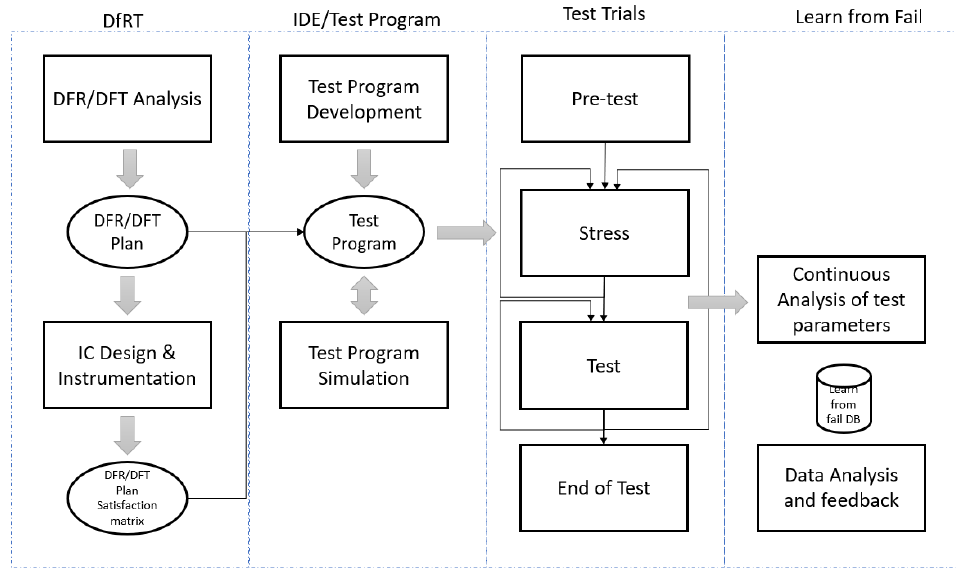
Figure 8. Test for Reliability Building Blocks.